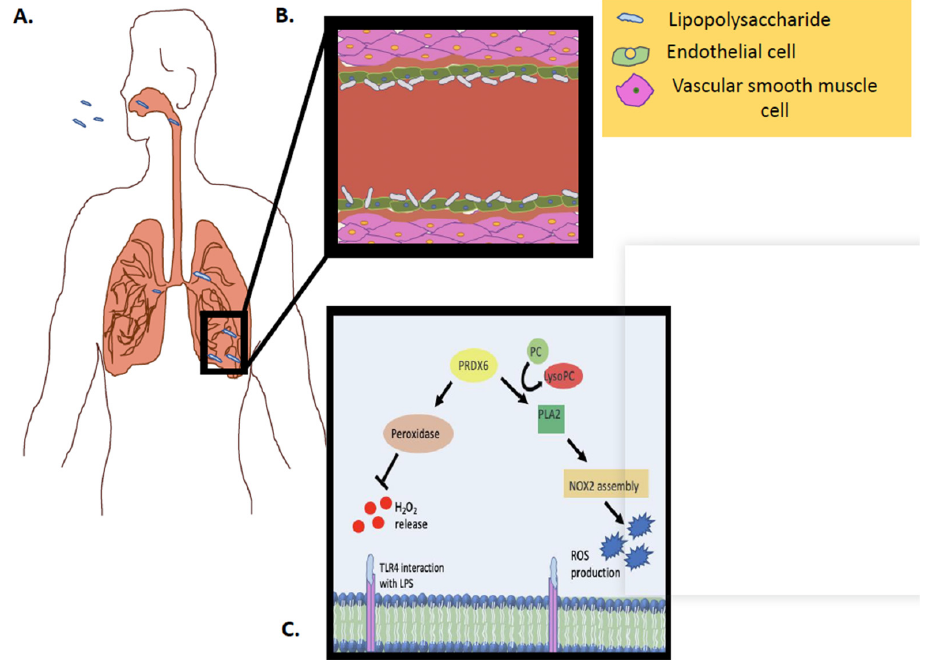
Figure 3. Schematic representation of Prdx6 activity (PLA 2 and peroxidase) in vivo, in response to an inflammatory stimulus. (A ) LPS inhalation and interaction with pulmonary capillary. ( B ) LPS inhalation and interaction with endothelial cells in pulmonary capillary. ( C ) LPS interaction with the endothelial cell membrane and the Prdx6–PLA2 activity as well as the Prdx6–peroxidase activity.